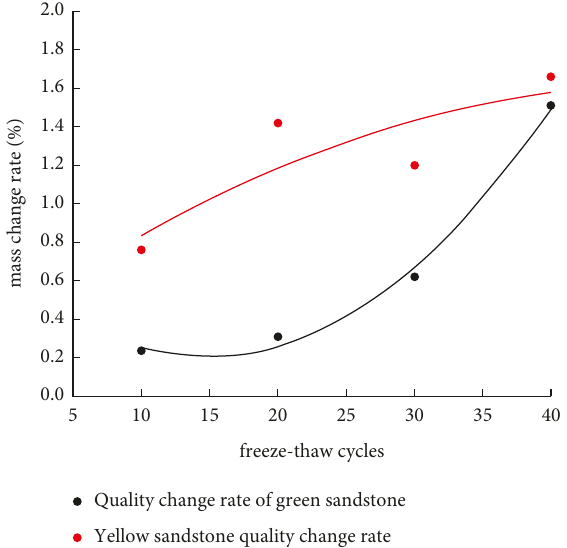
Figure 7: Fitting curve of mass change rate and number of freeze- thaw cycles.